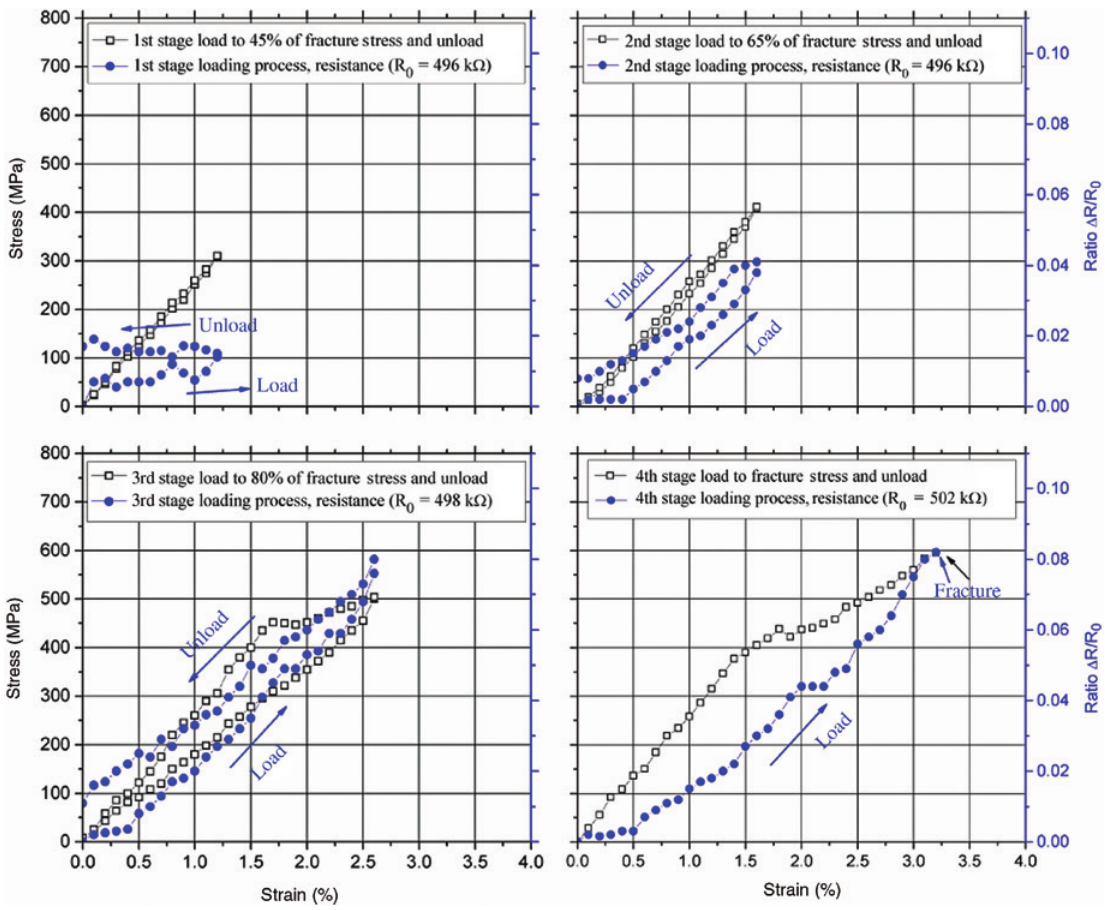
Figure 9: The three-point bending mechanical and electrical resistance results of specimen B for four incremental loading–unloading stages.